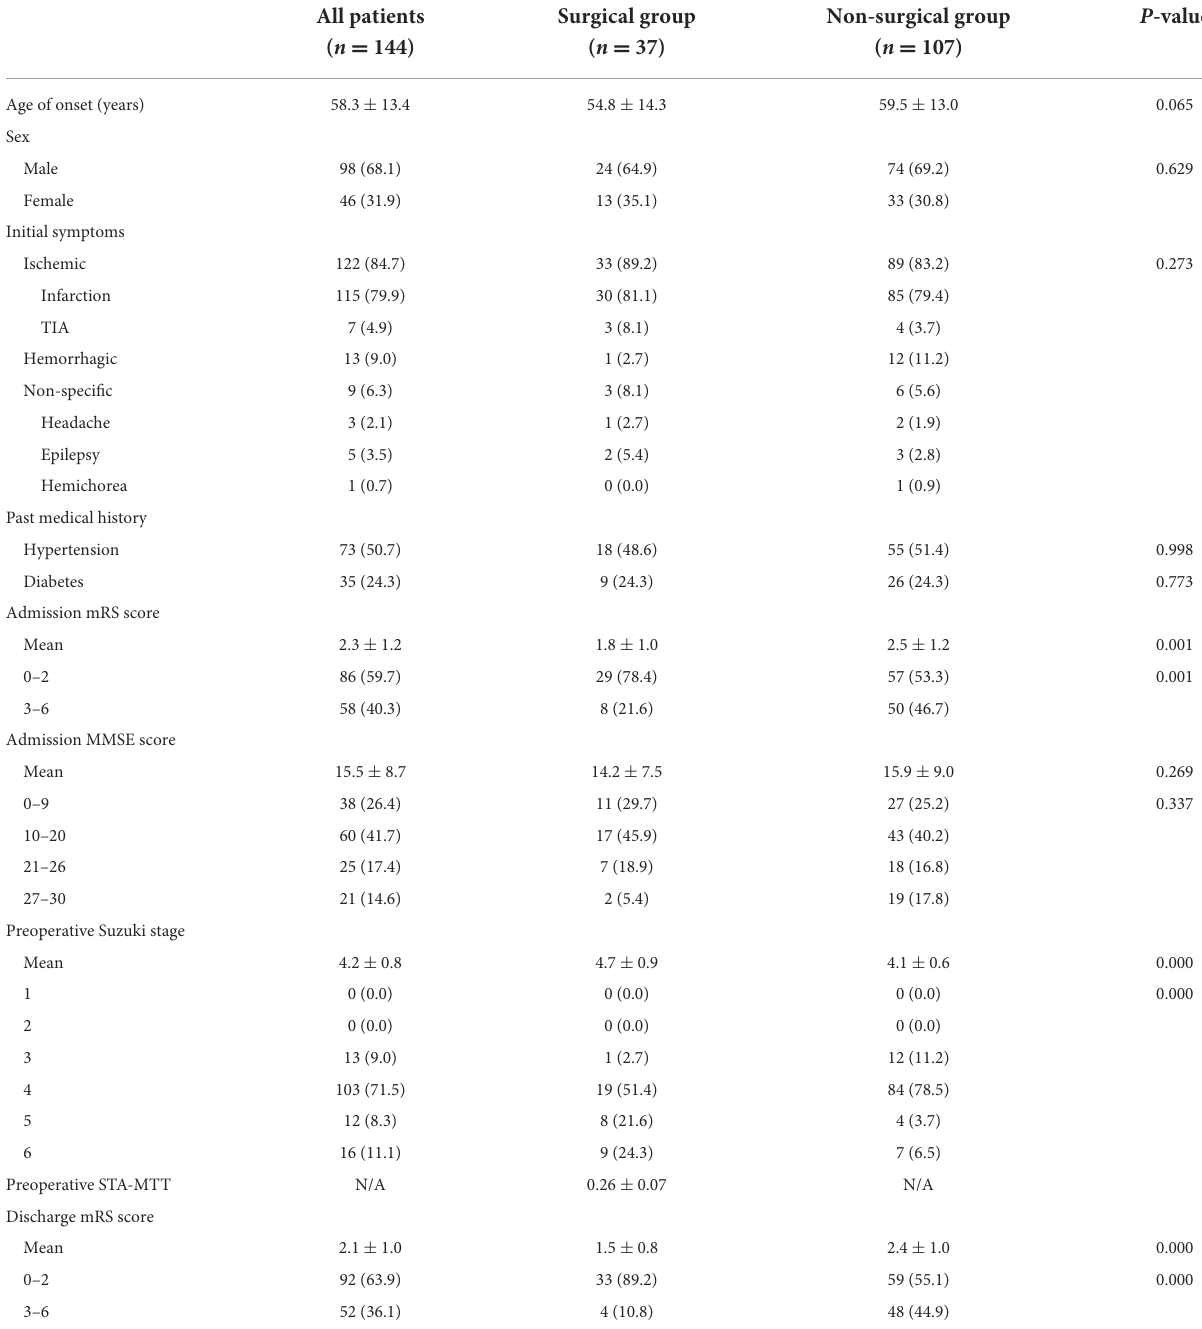
TABLE 1 Baseline characteristics of all